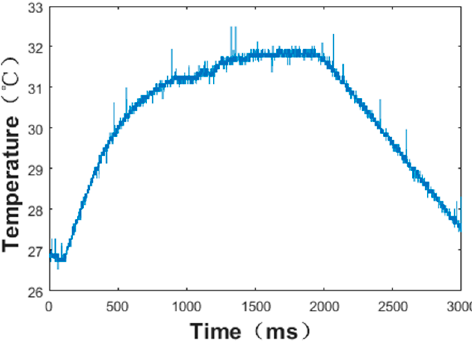
Figure 16. Temperature change of thermocouple hot junction under normal respiration conditions.